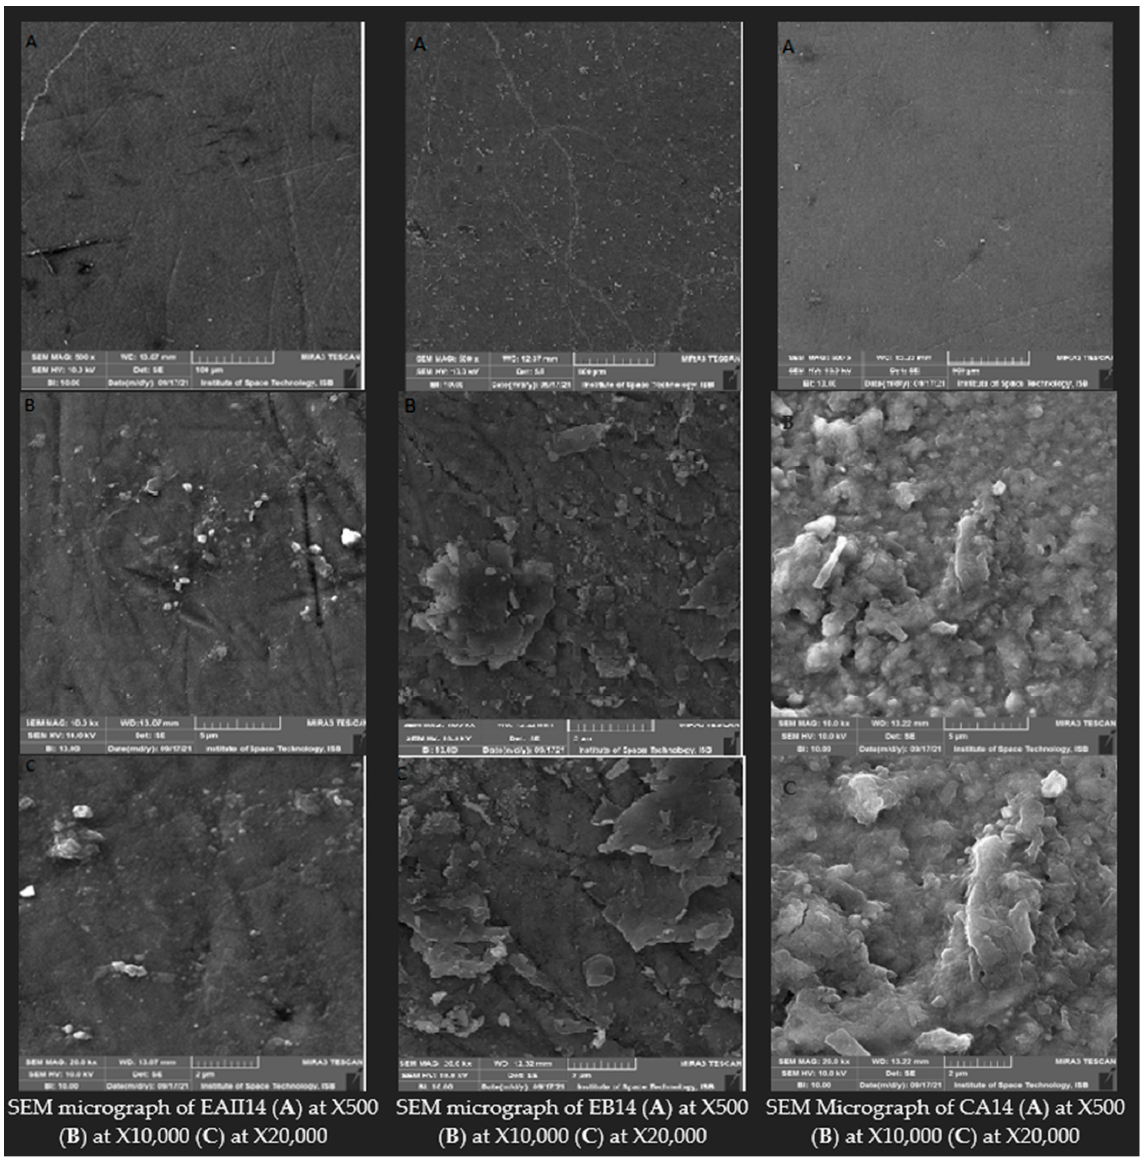
Figure 8. SEM images of EAII14, EB14, and CA14 at 500, 10,000, and 20,000 magni fi